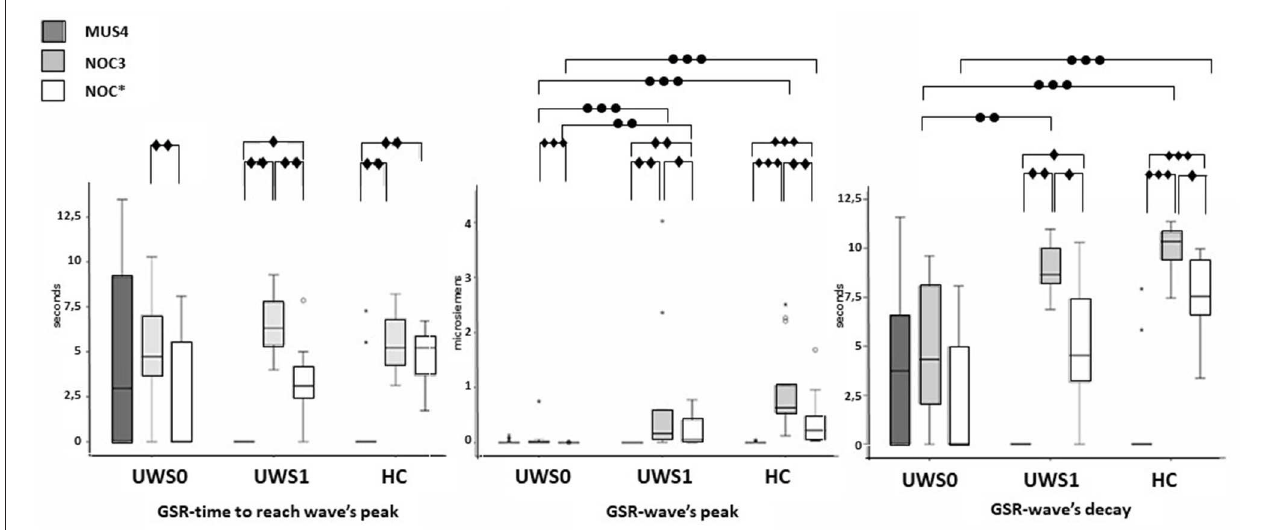
FIGURE 5 | Sequence A: boxplot of the GSR waves components. Time to reach the peak (left), wave’s magnitude (center) and wave’s decay (right) of each group were compared among them in MUS4, NOC3, and NOC* (diamond markers), and the groups (HC, UWS1, and UWS0) were compared among them for each session (point markers). The box represents the first and third quartile, the whiskers are the 1.5 interquartile range, the black lines are the medians, and points are outliers. Significant statistical difference: • p [0.002–0.003]; •• p 0.001; ••• p < 0.0001; circle: Statistical difference between = =